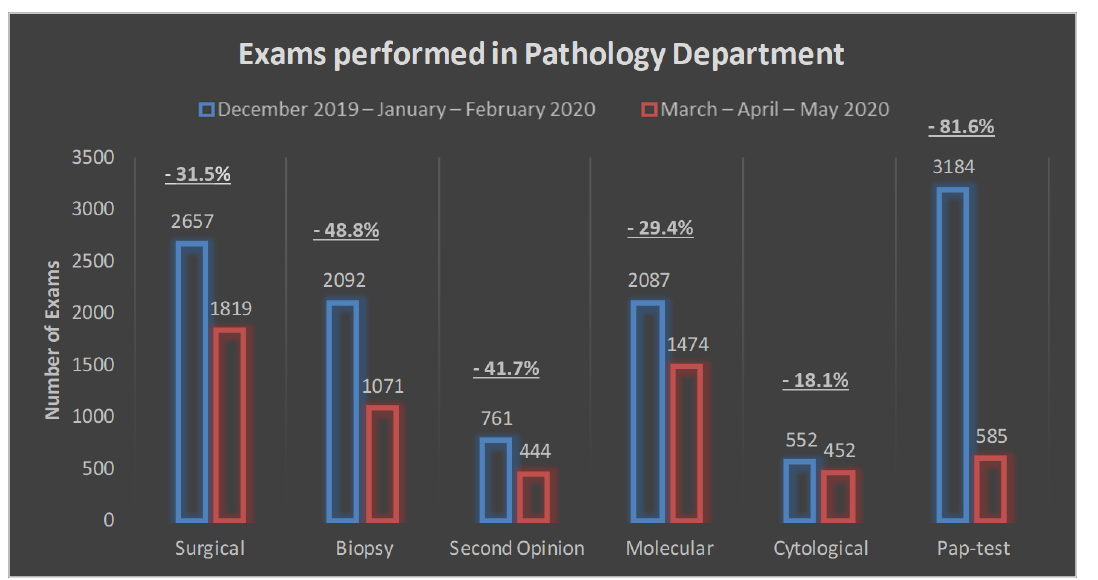
Figure 2. Number of exams performed between the pre-COVID-19 and the COVID-19 period. Table 2. Exams performed in pre-COVID-19 and in COVID-19 quarters.